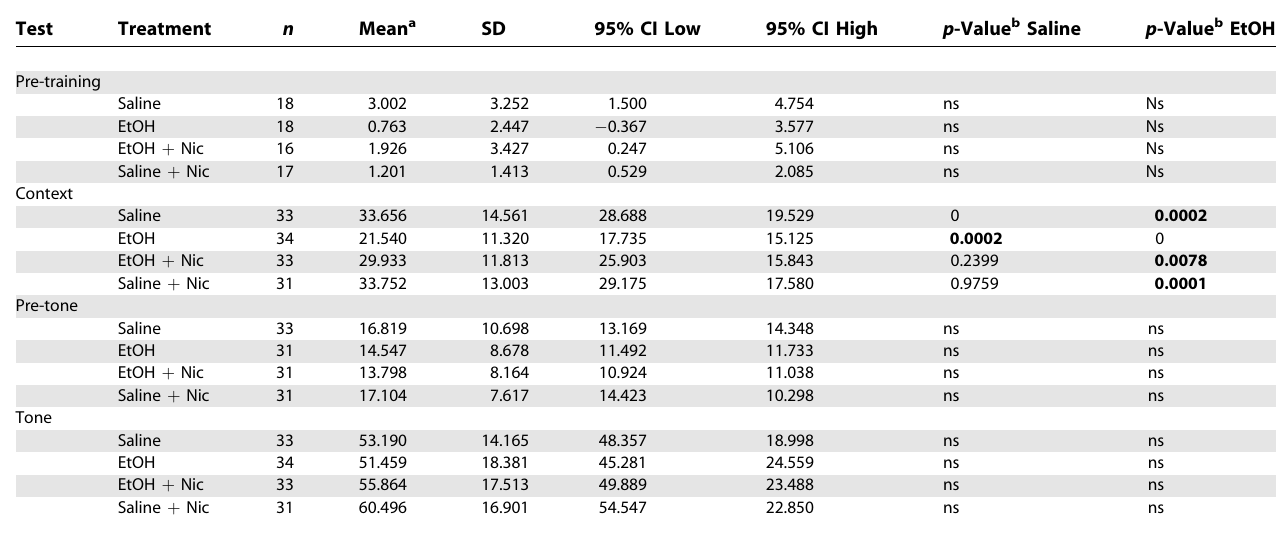
Table 2. Nicotinamide Prevents Ethanol-Induced Impairment Performance in the Contextual Fear-Conditioning Test